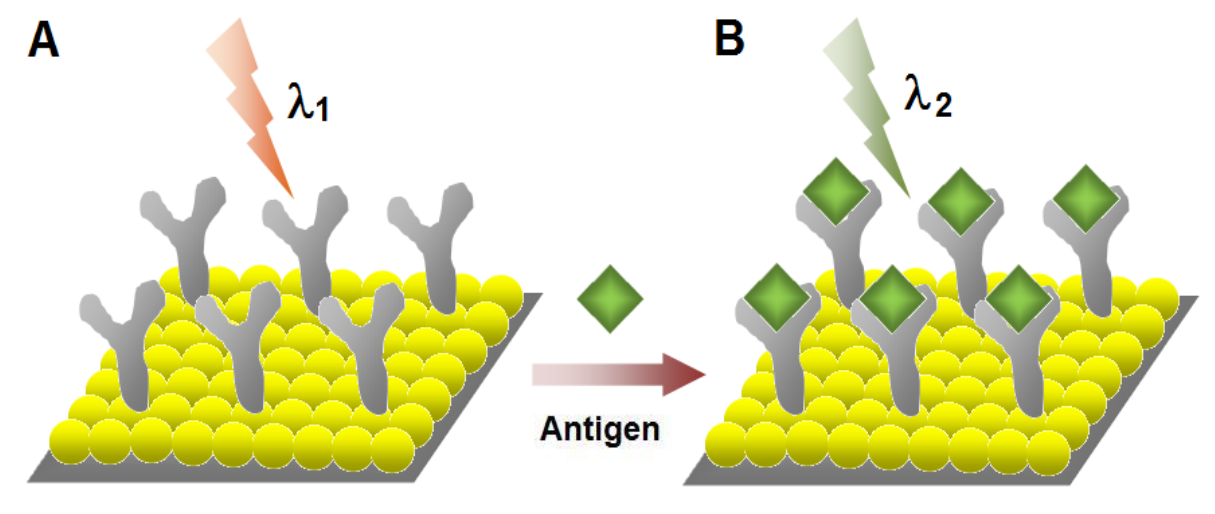
Figure 6. Schematic illustration for the label-free optical detection of target biomolecules using localized surface plasmon resonance (LSPR) of metal nanoparticles (NPs). (A) LSPR absorbance